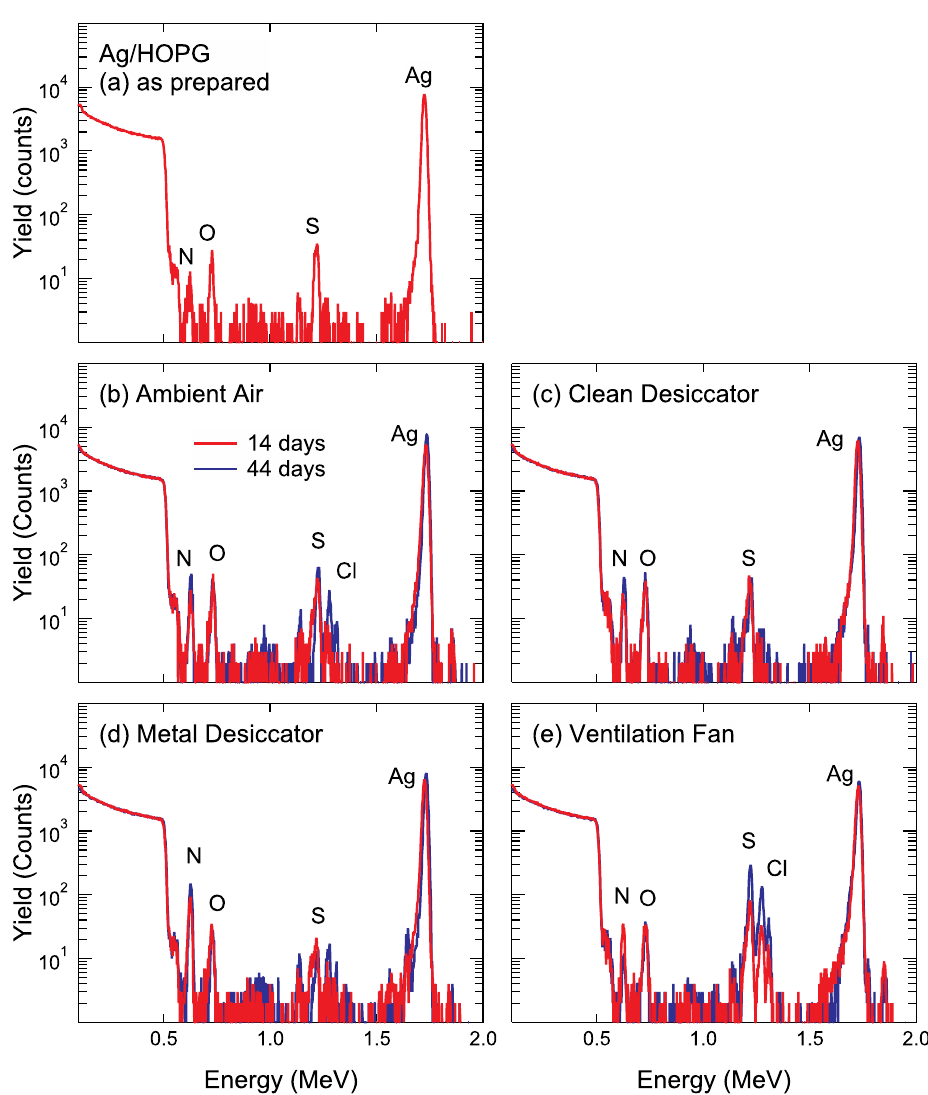
Figure 4. Backscattering spectra of ( a ) as prepared sample, Ag/highly oriented pyrolytic graphite (HOPG) stored ( b ) in ambient air, ( c ) inside the clean desiccator, ( d ) inside the metal desiccator and ( e ) near the ventilation fan for 14 days and 44 days.